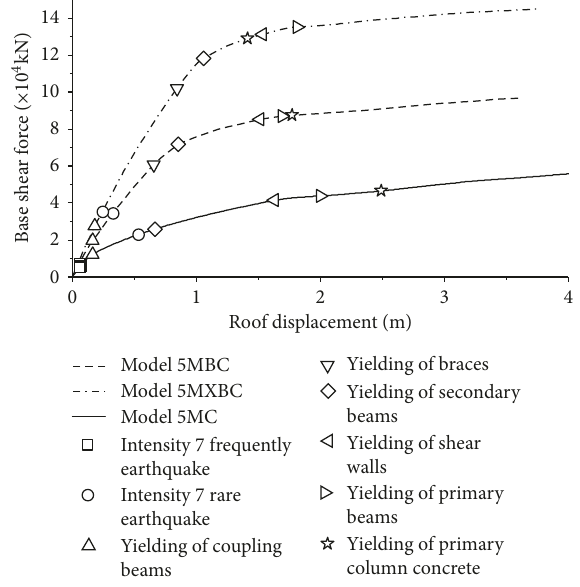
Figure 5: Pushover curves of three model structures: 5MB, 5MBC, and 5MXBC.